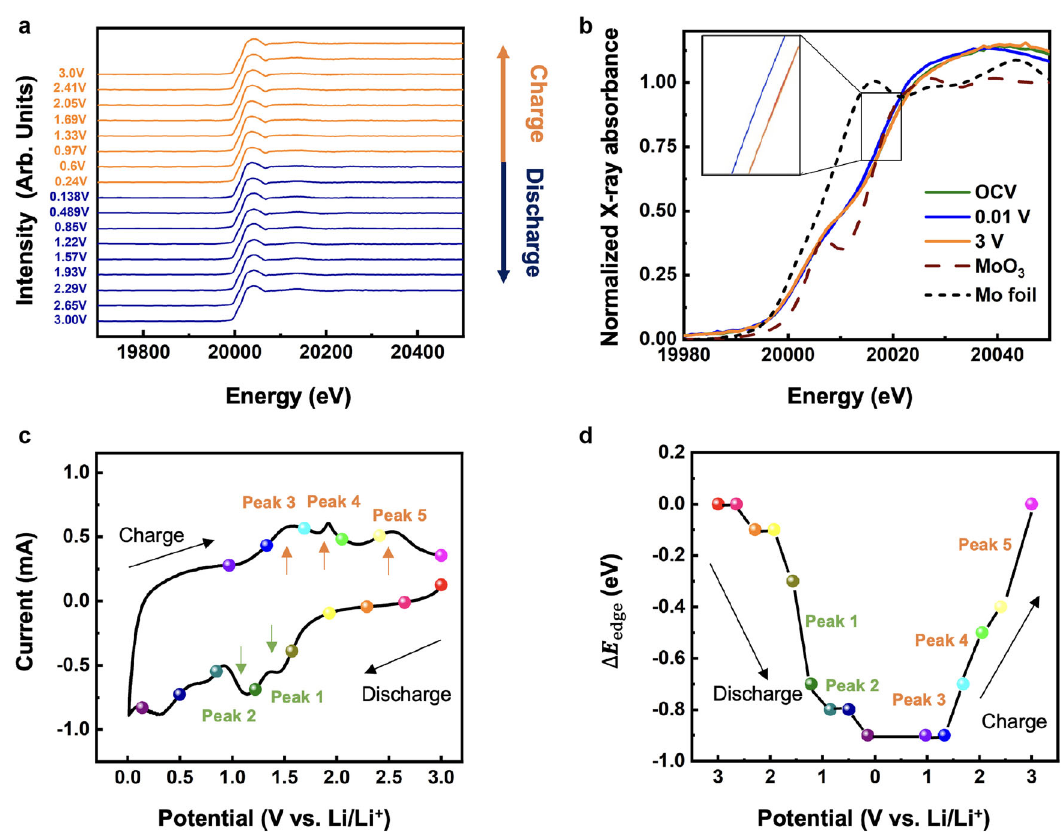
fi rst fully charge (3V) of MoS 2 , compared with MoO 3 and Mo metal foil reference materials. c The cyclic voltammograms of architected MoS 2 foam anode at a scan rate of 0.3mVs − 1 and ( d ) the corresponding absorption edge energy shift ( Δ E edge ) of architected MoS 2 foam at different potentials (labeled as colored dots in the cyclic